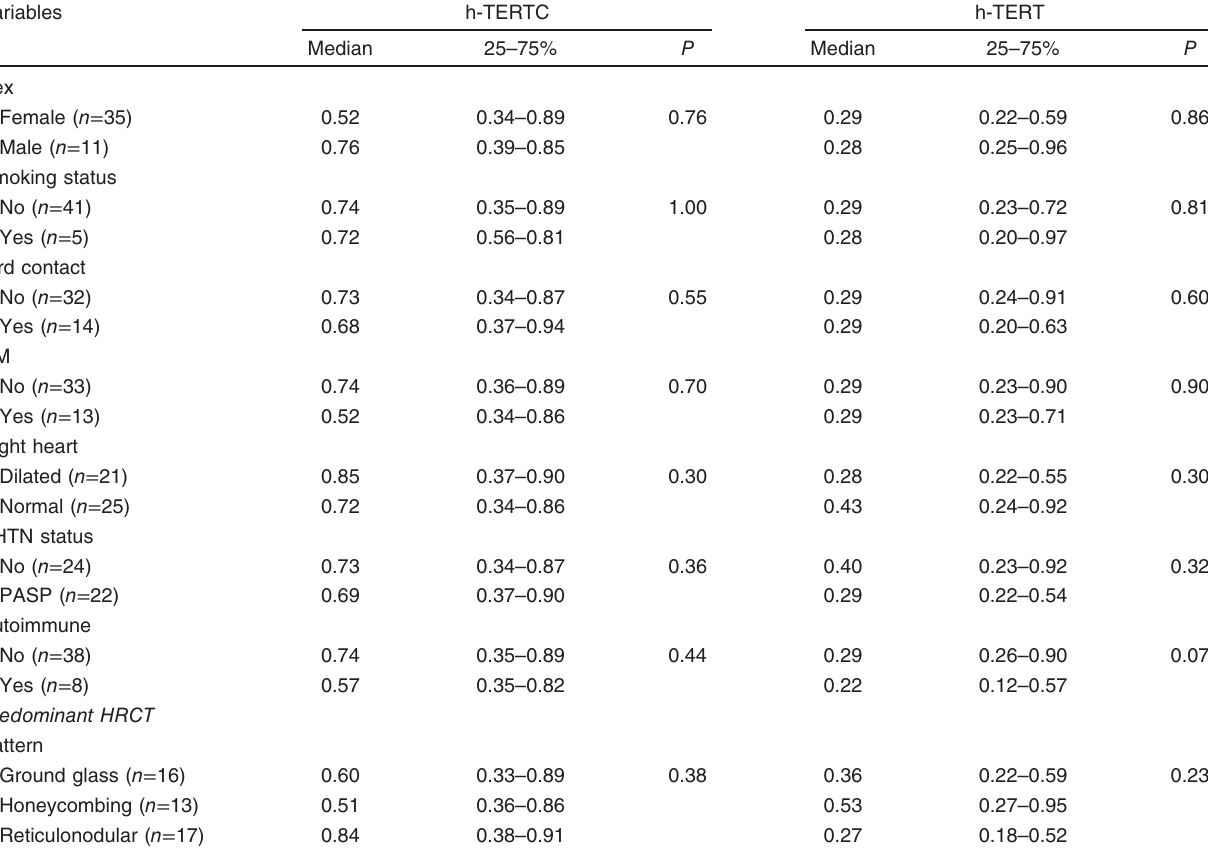
Table 4 Effect of different characteristics of patients with interstitial lung disease on h-TERT and h-TERC expression